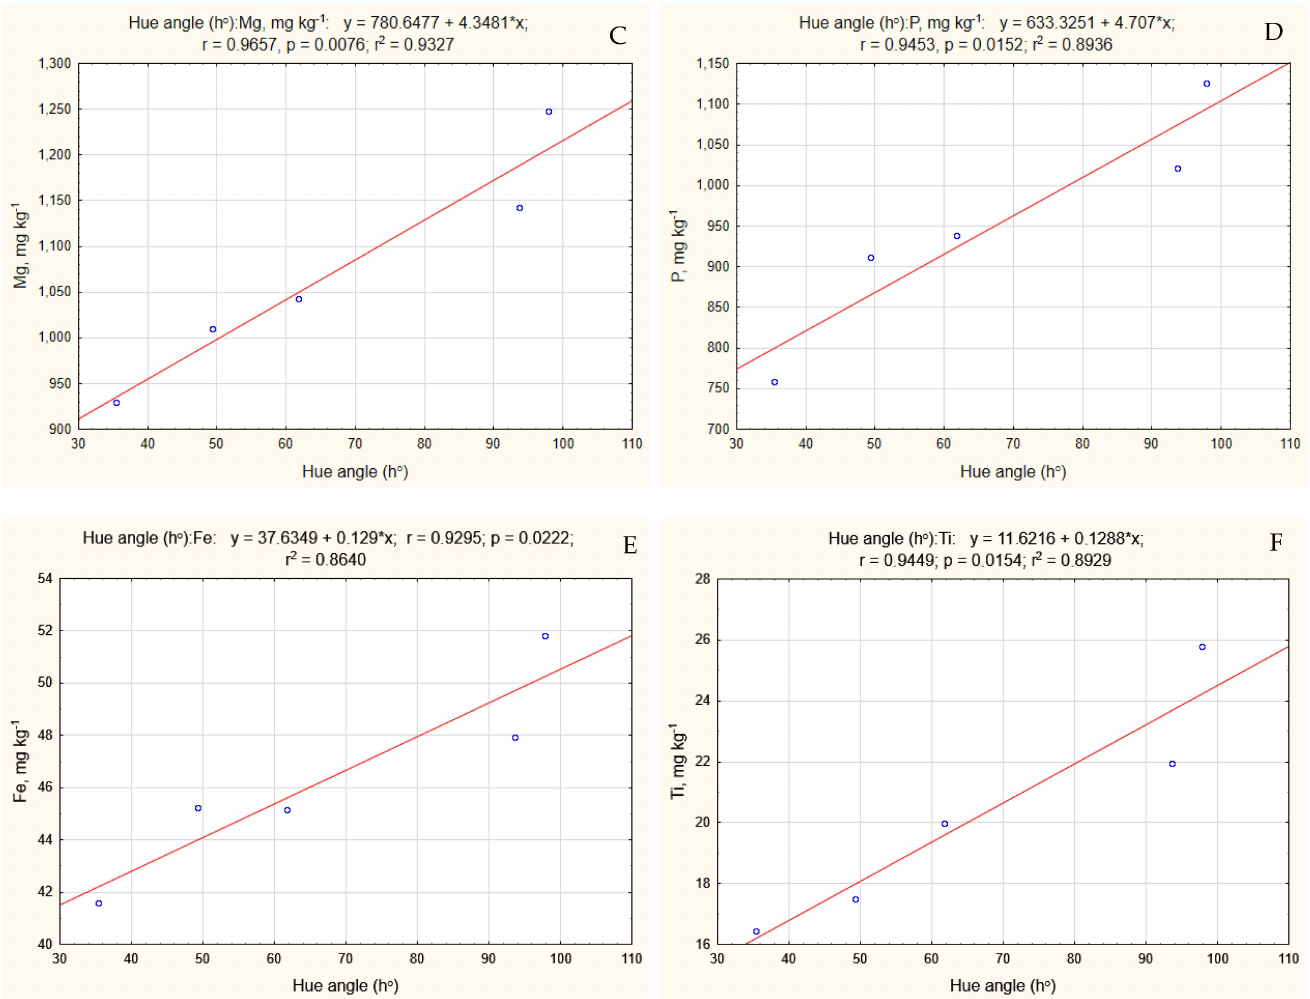
Figure 4. Correlations between hue angle (h ◦ ) and mineral element content. ( A )—potassium, ( B )—calcium, ( C )—magnesium, ( D )—phosphorus, ( E )— iron, ( F )—titanium (average for 2018–2020